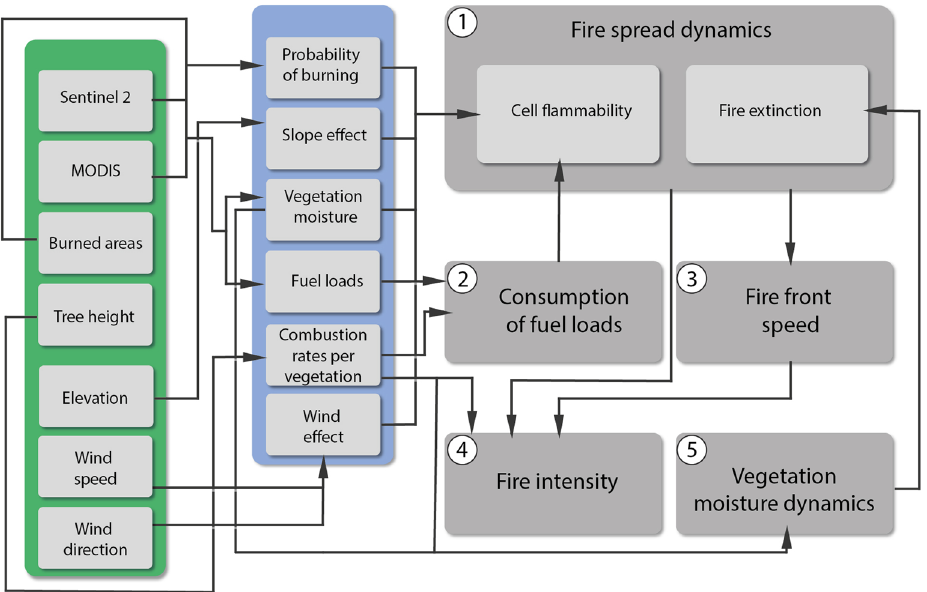
Figure 3. FISC-Cerrado main components. Input data (green), preprocessing of input data (blue) for feeding the cellular automata modules